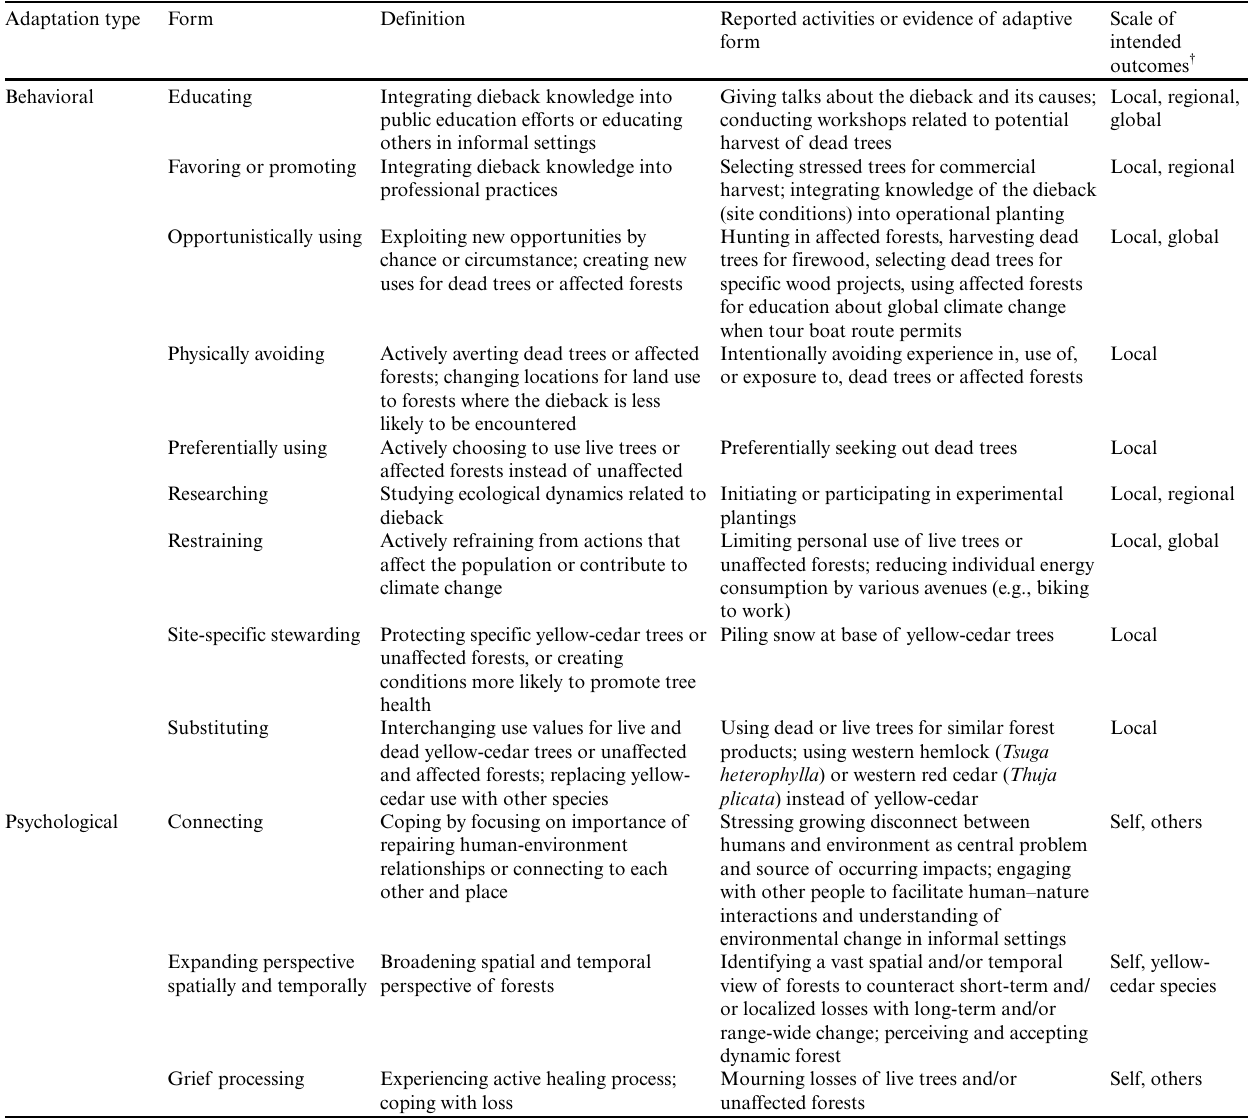
Table 2 . Adaptations that emerged from study